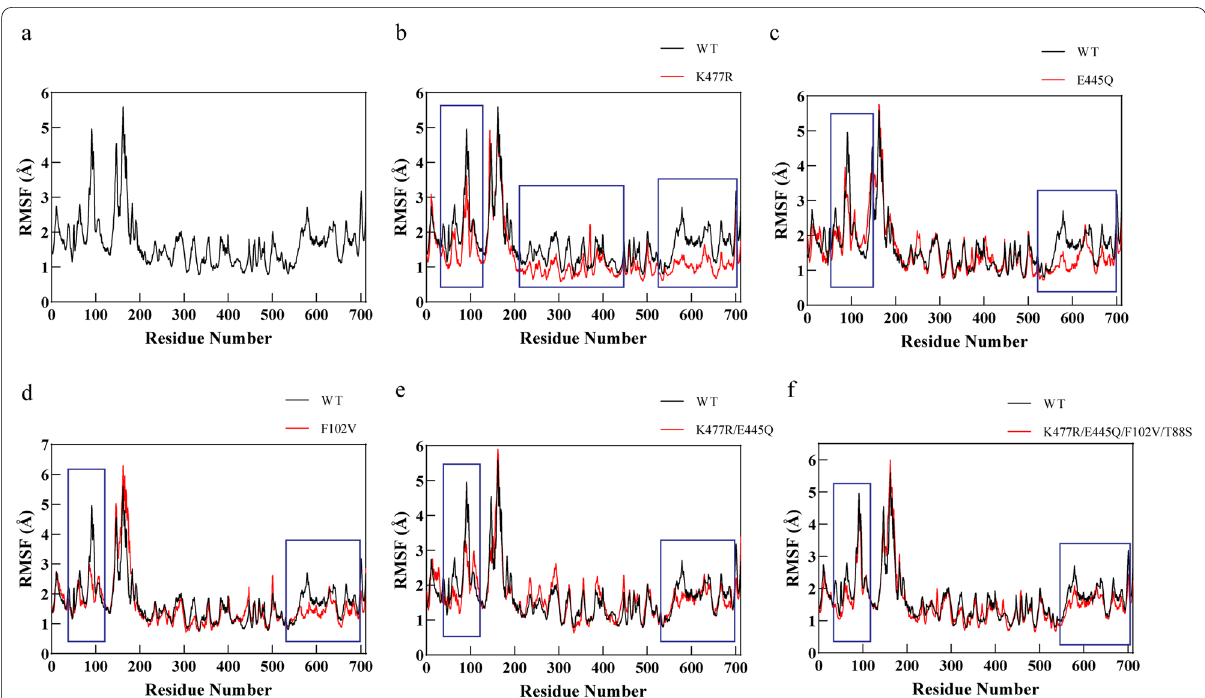
Fig. 6 RMSF of each residue in the wild-type CadA and its mutants. a WT, b K477R, c E445Q, d F102V, e K477R/E445Q, f K477R/E445Q/T88S/F102V. The black solid lines indicate the wild type; the red solid lines indicate the mutants. The blue boxes indicate the areas where the RMSF values of the mutants have decreased